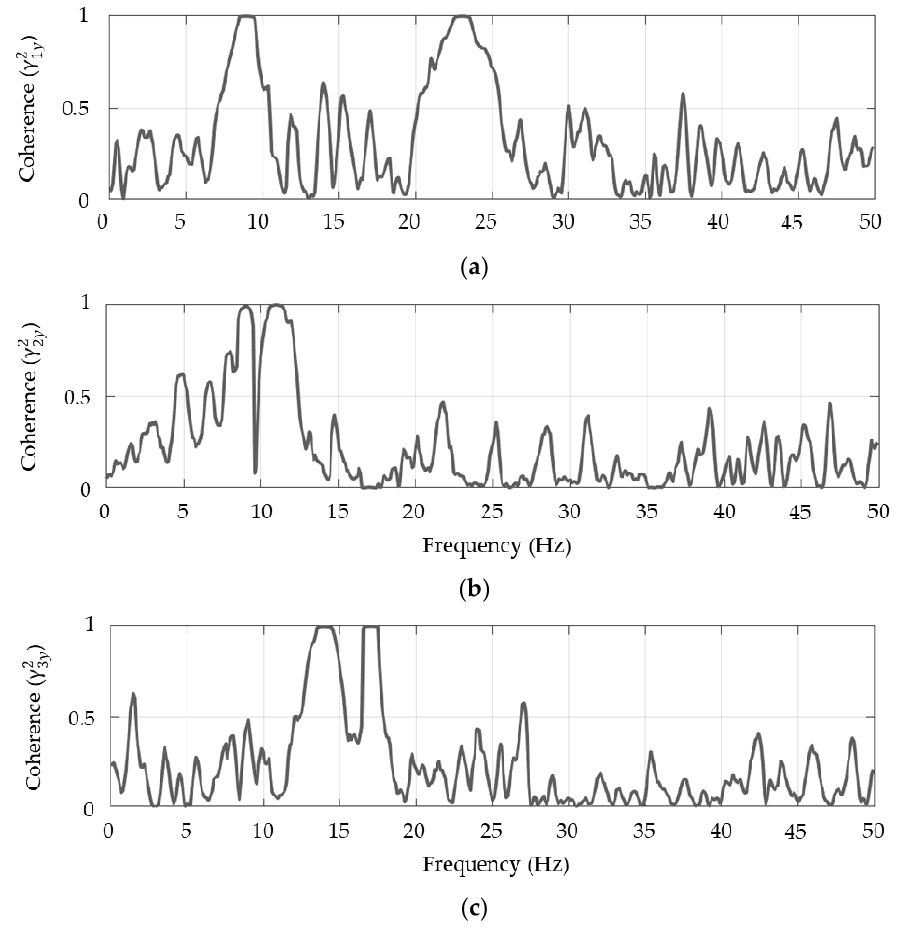
Figure 8. Ordinary coherence based on ICA: ( a ) γ (cid:2869)(cid:3052)(cid:2870) , ( b ) γ (cid:2870)(cid:3052)(cid:2870) , ( c ) γ (cid:2871)(cid:3052)(cid:2870) .